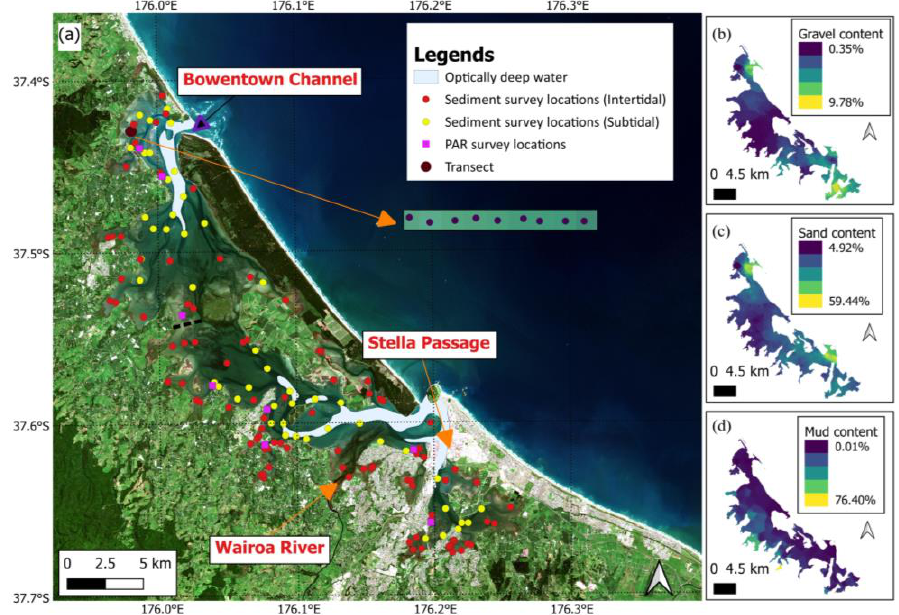
Figure 1. Optically deep-water regions (where no corrections were needed) and in situ measurement (sediment and PAR) locations in Tauranga Harbour. ( a ) The in situ sediment data in the intertidal (for regression) and subtidal (for extrapolation) were provided by Clark et al. [26] (and Bay of Plenty Council) and Ellis et al. [27], respectively (see Methods). The PAR data were provided by Flowers et al. (in prep.). The location of the spatial transect shown in the figure in Section 2.2.1 is marked with a black circle. The black dashed line is the natural barrier that isolates Tauranga Harbour into the northern and southern harbours. The selected transect was close to the northern entrance of the harbour. ( b – d ) Maps of sediment content percentages (gravel, sand and mud) from Rullens et al. [25]. The background image is from Sentinel-2.